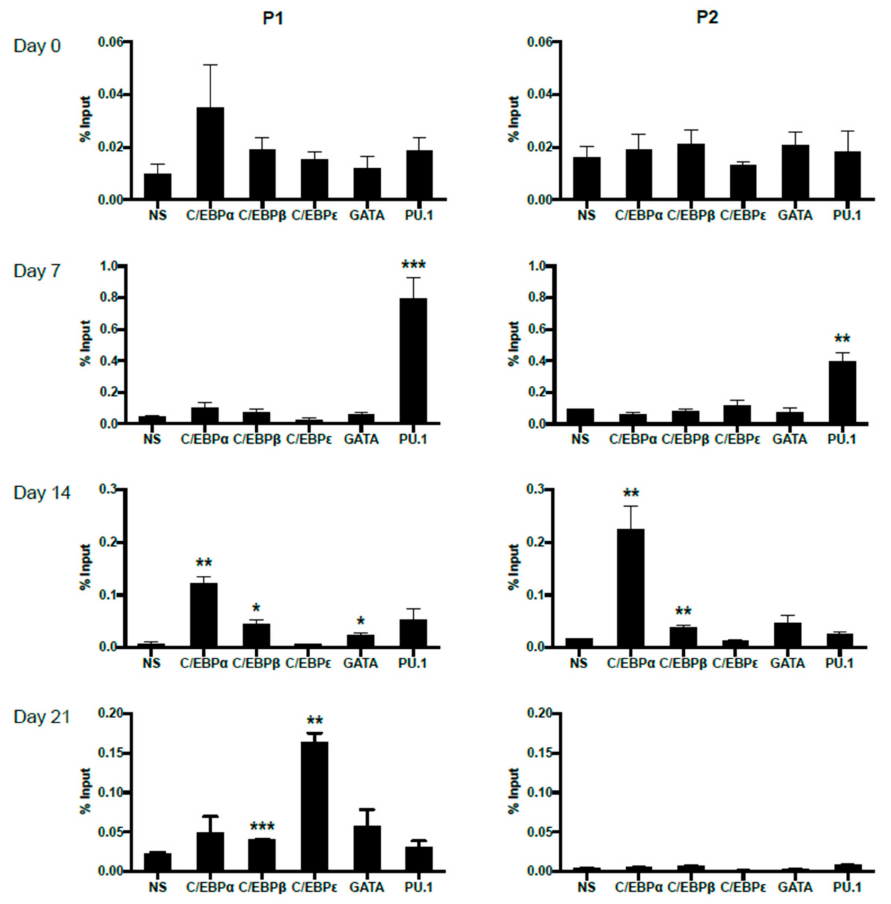
Figure 7. Differential in vivo occupancy of the IL5RA P1 and P2 promoters by important transcription factors in differentiating CD34 + progenitors as demonstrated by chromatin immunoprecipitation (ChIP). Chromatin immunoprecipitation was performed at days 0, 7, 14, and 21 of differentiating eosinophil progenitors to follow dynamic changes in transcription factor binding to the IL5RA P1 (left) and P2 (right) promoters. One representative experiment is shown out of 2–3 independent experiments. NS: non-specific Ig control. Significant enrichment by each antibody was compared to NS. * p < 0.05 ** p < 0.01 *** p <